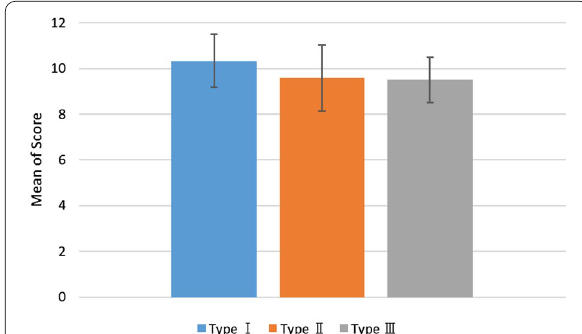
Fig. 14 Means of the score for each type during the reconnaissance activity